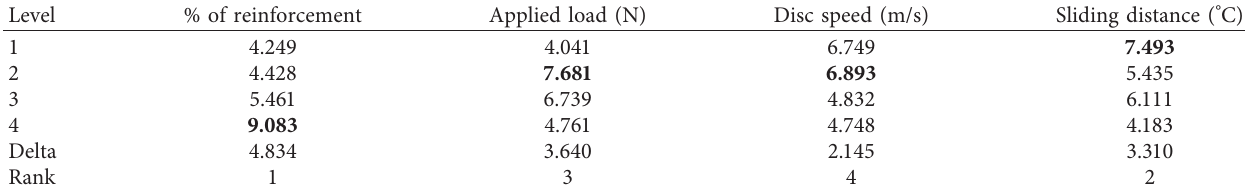
Table 6: Response table for signal to noise ratios (wear test)—smaller is better.